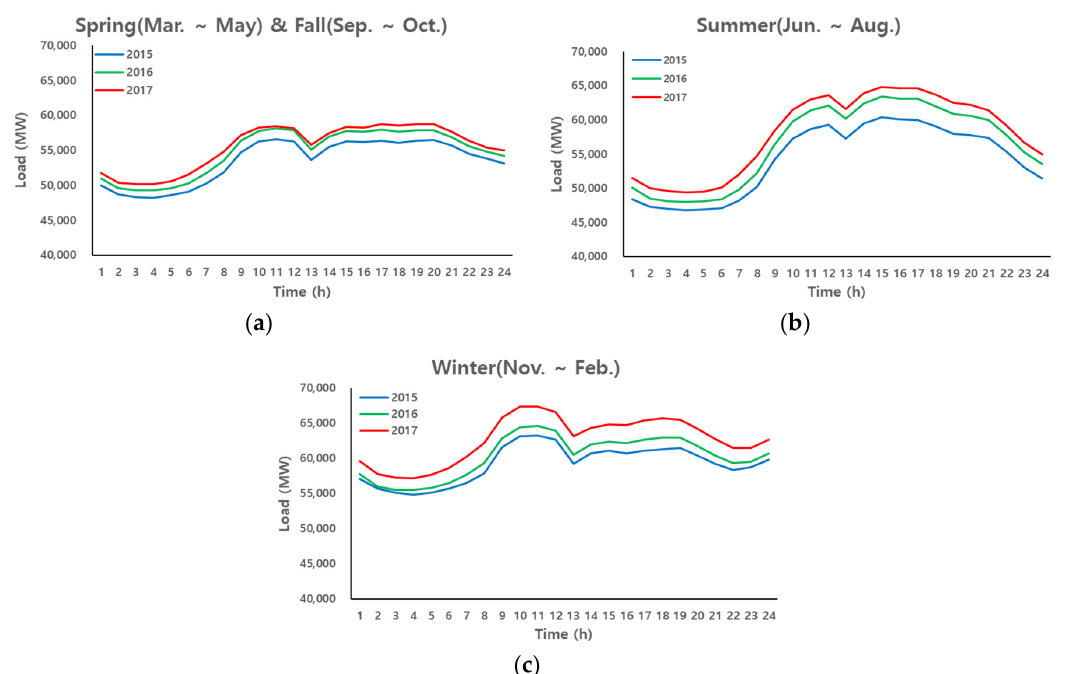
Figure 2. Seasonal average net load curves for South Korea in each year from 2015 to 2017: ( a ) for spring (March, April, May) and fall (September, October); ( b ) for summer (June, July, August); and ( c ) for winter (November, December, January, February). Table 3. Seasonal peak load time in each year from 2015 to 2017 in Figure 2.